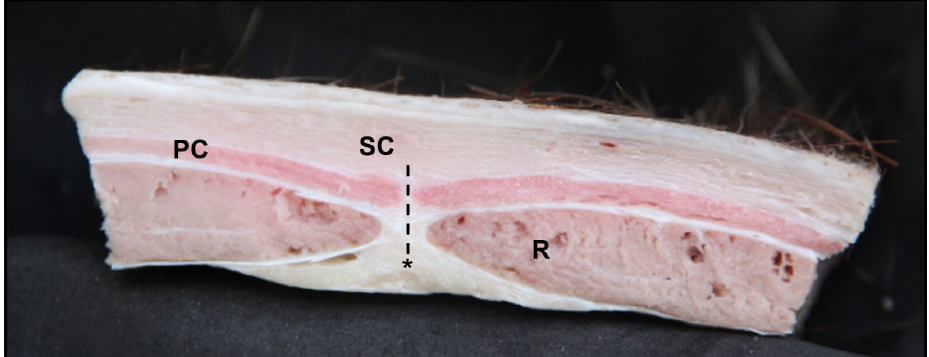
Figure 4. Transverse section of the post-umbilical region . SC: subcutaneous tissue; PC: cutaneous muscle; R: rectus abdominis muscle; dashed line: linea alba; asterisk: adipose tissue.